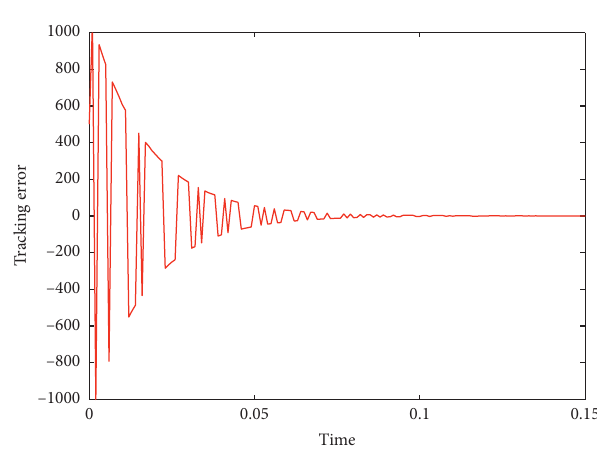
Figure 9: The curve of tracking